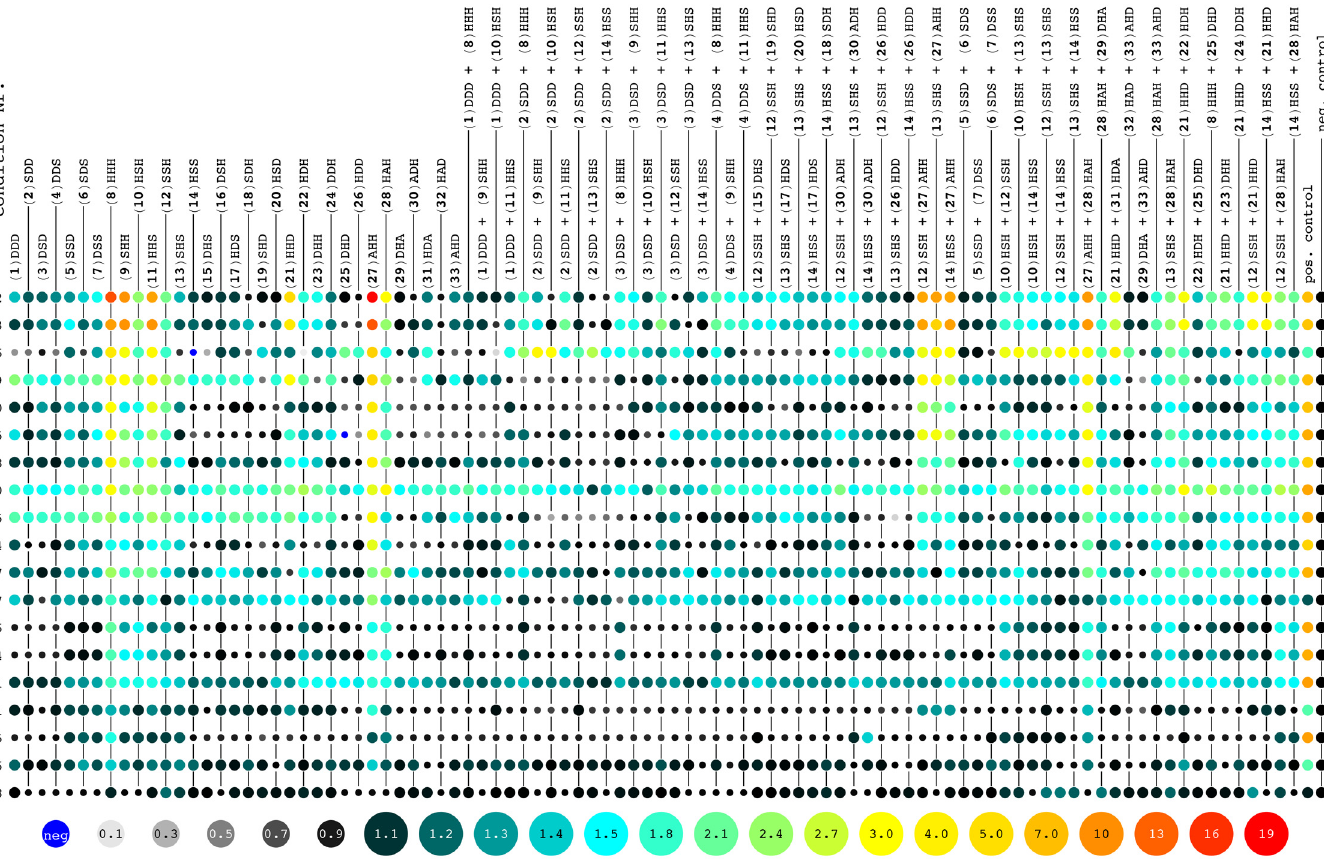
Fig 1. Activity screens of peptide amyloids in various conditions. The hydrolysis rates of 4NPA measured for each of the peptide amyloids (in columns) are shown as a ratio to the negative control (buffer) with color-codes as indicated at the bottom of the Figure. A color code from black (rate ratio of 1.0) to light blue (1.5) to red (19) is used. Activities below the negative control are indicated with smaller disks and color-coded from light grey to black. Occasionally observed negative reaction rates are indicated by small blue disks. The peptide amyloids were tested in a total of 46 conditions of which 19 conditions are shown here (in rows). The peptides are numbered according to Table 2, including a short nomenclature highlighting only the variable residues ( e . g . the peptide Ac-YV D V H V S V-CONH 2 is abbreviated DHS). The conditions are sorted top-down with the highest observed activity at the top. A detailed list of the conditions tested are shown in Table B in S1 File, while below a compressed introduction to the different conditions is listed: (2) pH 7.3 with ZnCl 2 (control for 33 without heating), (33) condition 2 and heated to 95°C for 1 h prior to screening, (46) condition 2 and screened in 50% DMSO, (39) condition 2 and screened with 4.75 M NaCl, (40) condition 2 and screened with 0.2 M MgCl 2 , (45) condition 2 and screened in 90% EtOH, (38) condition 2 and screened with 0.2 M NaCl, (30) pH 7.3 with ZnCl 2 and 1 M Na 2 SO 4 , (35) pH 7.3 and screened in 4.75 M NaCl, (34) pH 7.3 and screened in 0.5 M NaCl, (37) pH 7.3 and screened in 2 M MgCl 2 , (27) pH 7.3 with ZnCl 2 and 0.2 M MgCl 2 , (6) pH 7.3 with NiCl 2 , (4) pH 7.3 with CoCl 2 , (1) pH 7.3 without other additives, (41) condition 2 and screened in 2 M MgCl2, (5) pH 7.3 with CuCl 2 , (36) pH 7.3 and screened in 0.2 M MgCl 2 and (8) pH 4.0 without other